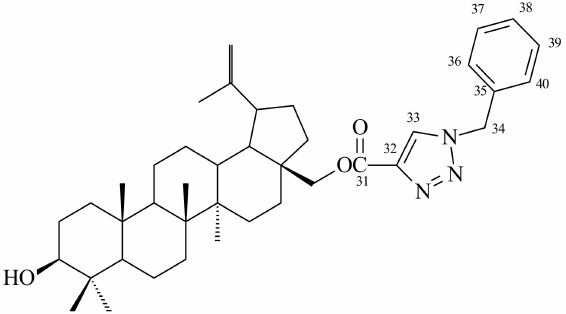
Figure 2. Chemical structure of triazole 5a